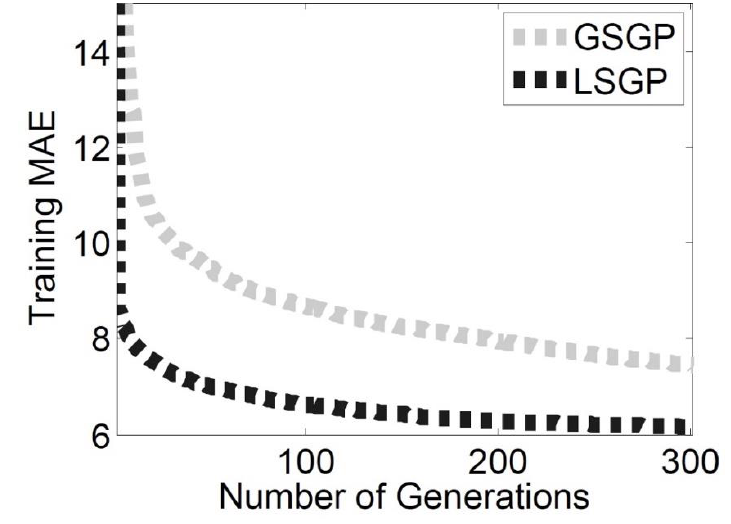
Figure 2. Training Mean Absolute Error (MAE). The plots show the median over 100 runs. The training MAE is expressed in Euros. The light gray line represents Geometric Semantic Genetic Programming, while the black line represents Geometric Semantic Genetic Programming with Local Search.